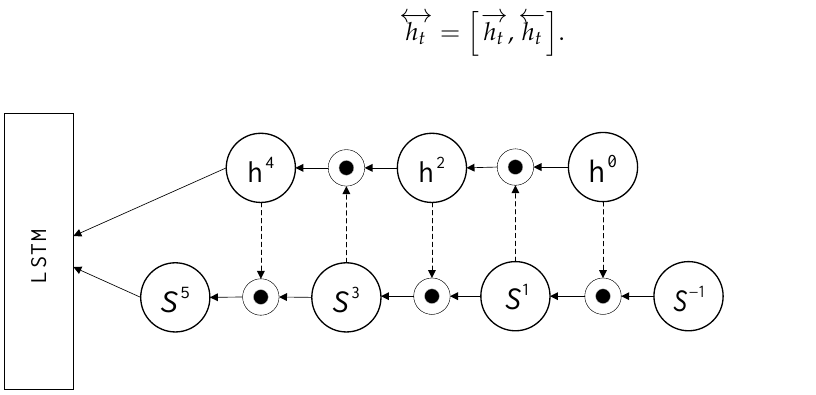
Figure 2. Gate mechanism of the extended LSTM. The previous state h 0 = h prev is transformed linearly, passing through the sigmoid and S − 1 gates to produce S 1 , where S − 1 is the representation of the input sentence S. After repeating this gating interaction five times, the final representation of sentence S 5 and the previous state h 4 are fed to the